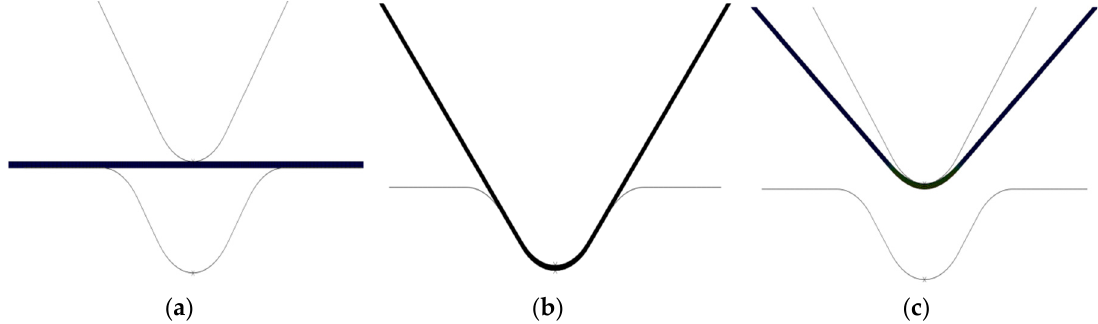
Figure 12. Finite element simulation of the V-bending: ( a ) before bending, ( b ) bending and ( c ) springback.